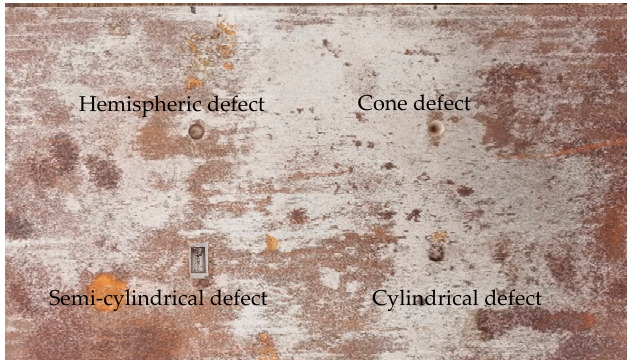
Figure 18. Schematic diagram of cylindrical defect on metal surface.